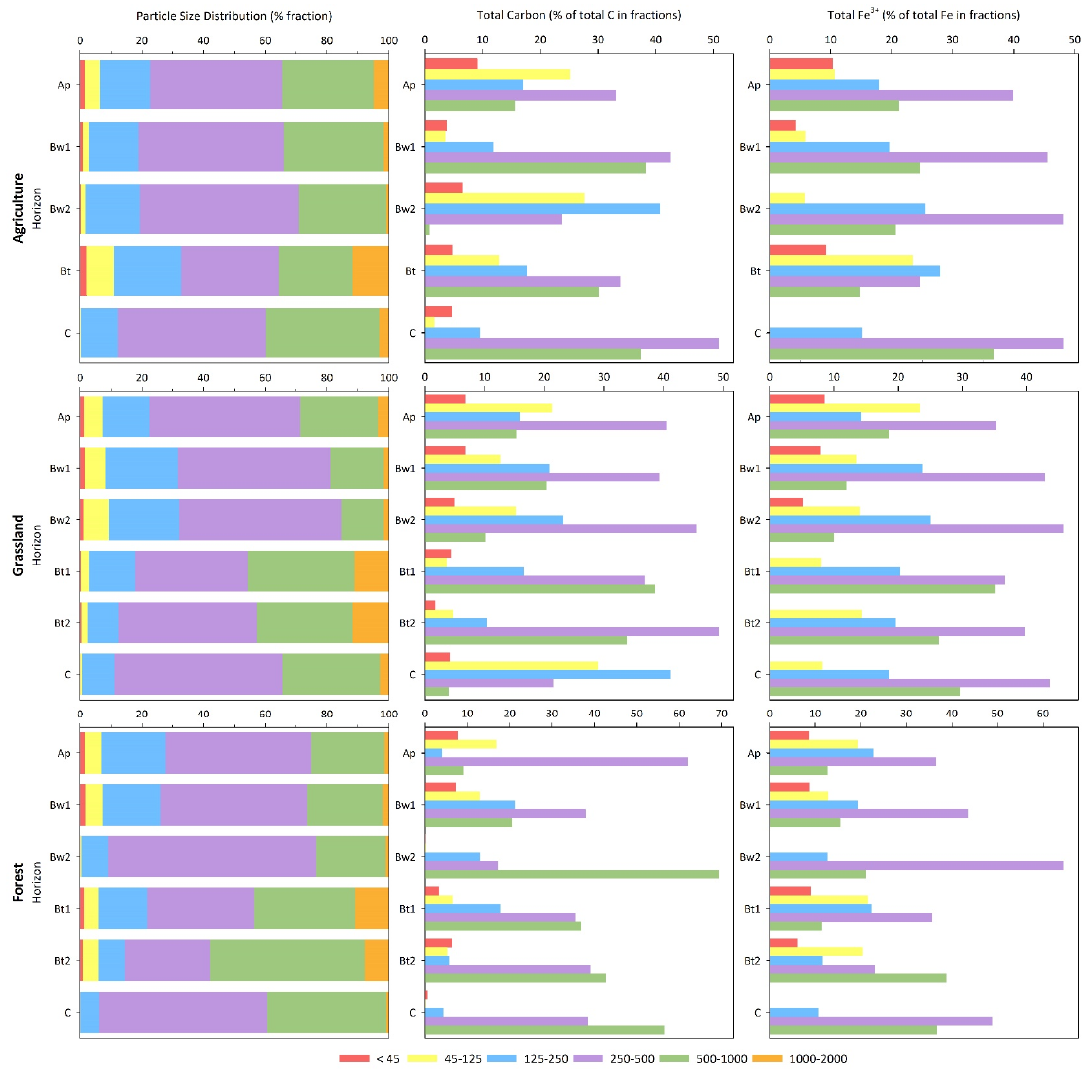
Figure 6. Percentage of bulk soil for particle size distribution, total carbon, and total iron (Fe 3+ ; CDB extractable) in each fraction (μm) of the horizons of three sandy Alfisols under different land use.